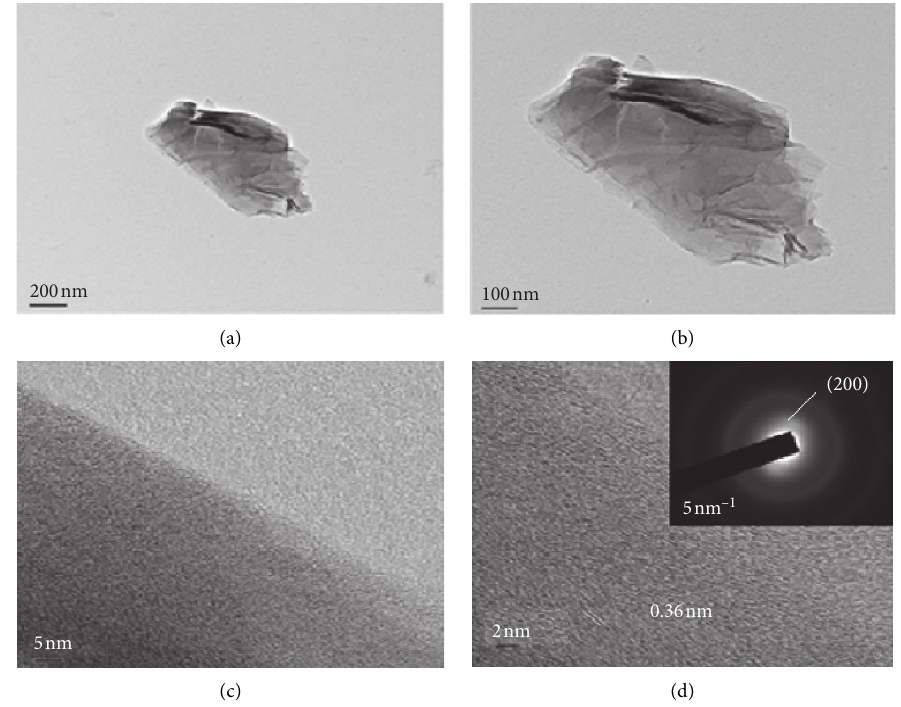
Figure 8: (a–d) TEM image of rGO along with EDAX analysis, and the inset is SEAD pattern of be clearly seen that the rGO samples are the crippled and graphene. This image depicted that the sample consists of wrinkled structure which inhibits the restacking of the scrolled, wrinkled, and transparent structures which were graphene sheets together. The TEM micrograph of rGO often the indicators of a few layers of rGO sheets. It can also